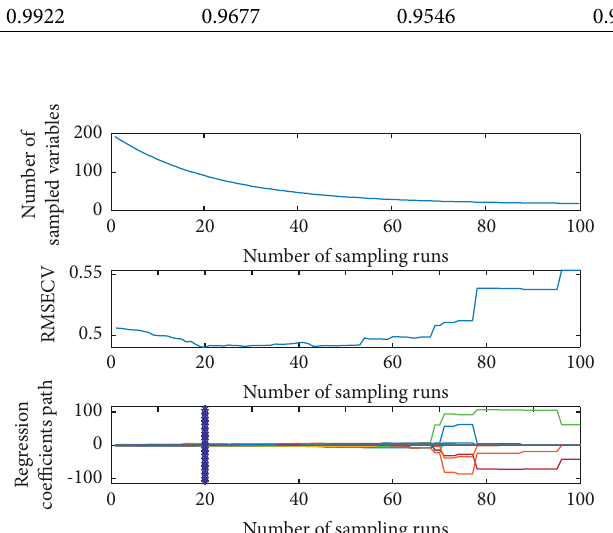
Figure 6: Process and results of A-RAW-CARS characteristic wavelength selection. UVE plot when 5-components are considered in the PLS model